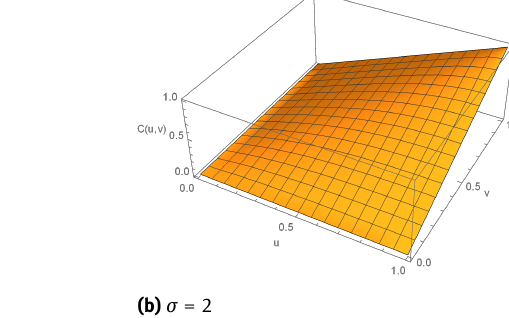
copula is characterized by asymptotic tail dependence, whose strength grows with σ . In Figure 3 two simula- tions are given, and in both of them it is possible to notice the expected tail behavior: observations in the top right corner are definitely more